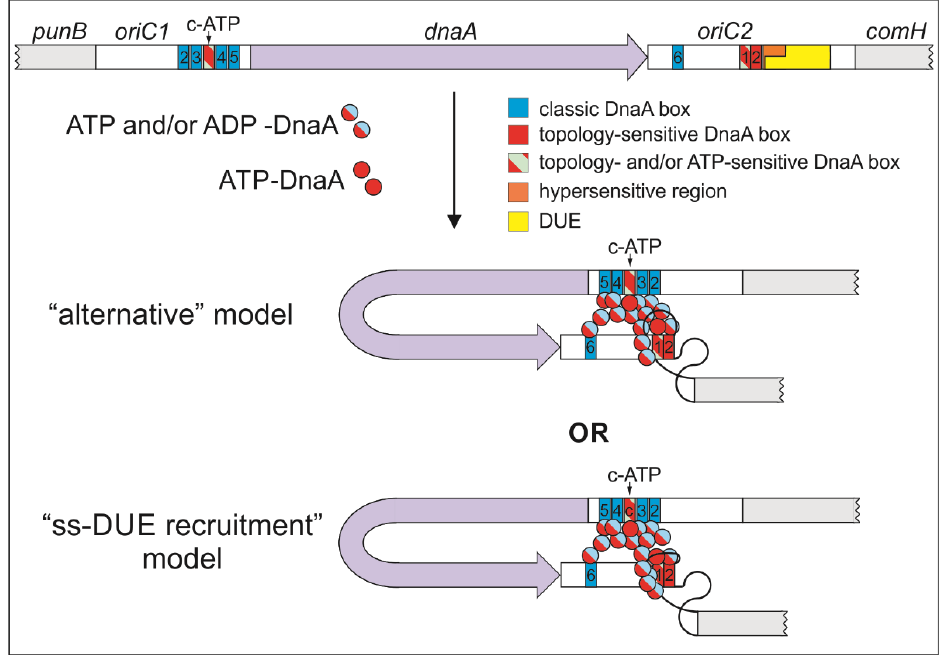
Figure 8. Schematic representation of possible H. pylori orisome structures on bipartite oriC . Boxes c-ATP and ts1 are bound exclusively by ATP–DnaA, whereas both DnaA forms, ADP-bound and ATP-bound, interact with classic DnaA boxes. The nucleotide status of the DnaA (ATP or ADP) forming the complete oligomer is unknown. The binding of DnaA to dsDNA leads to DNA unwinding. DnaA bound to ssDNA stabilizes the interaction of the protein with DnaA box ts1 either by recruitment of additional DnaA molecules (“alternative” model) or by simultaneous ssDNA and dsDNA binding (“ss-DUE recruitment” model). Whether or not there is additional stabilization/orientation of ssDNA–DnaA oligomer by DnaA bound to oriC1 of H. pylori is also an open question.